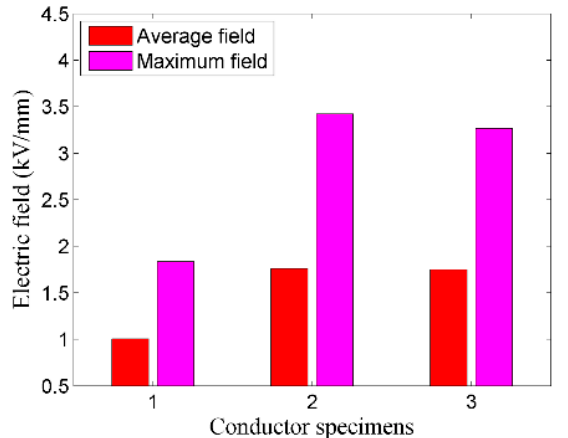
Figure 10. Location and magnitude of the maximum electric field for the proposed pliable GIL regarding ( a ) specimen 2 and ( b ) specimen 3 of Table 3.